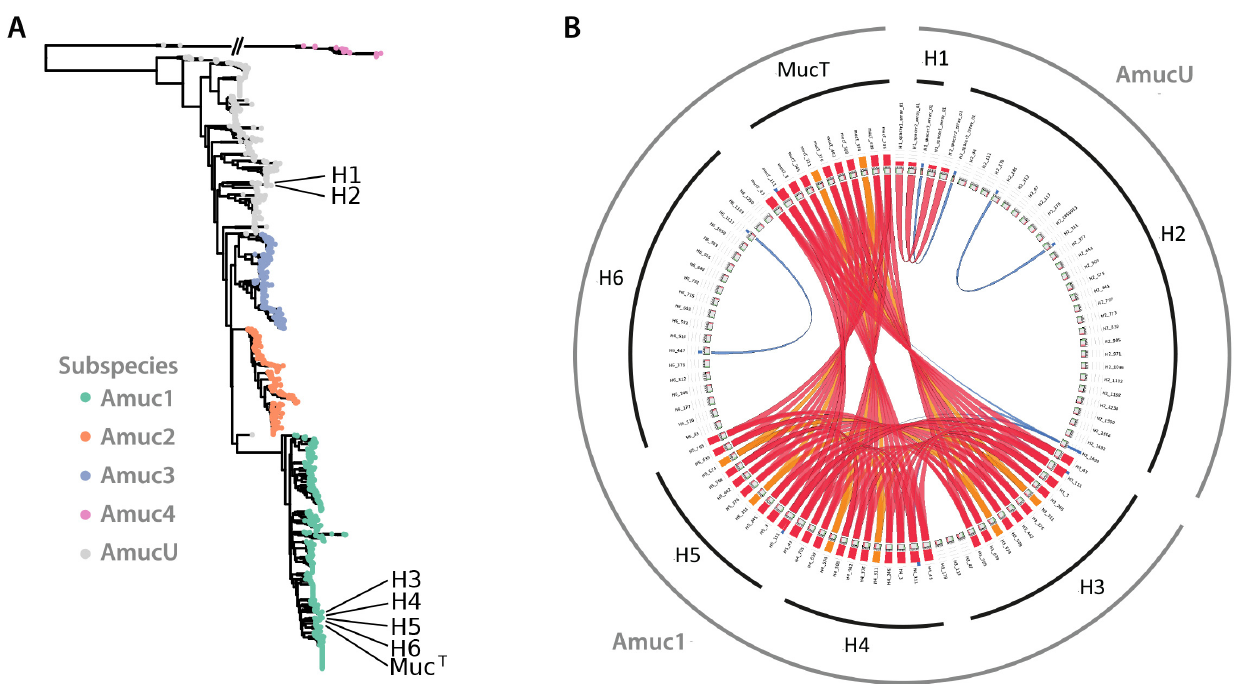
Figure 1. ( A ). Genome-based clustering of the new human isolates and the type-strain Muc T . The six new isolates (H1–H6) were positioned in the tree that was constructed earlier based on available (draft) genomes [22]. ( B ). Schematic representation of CRISPR repeats of the new human isolates and the type-strain Muc T . All CRISPR repeats are compared with each other. The red ribbons indicate a relatively high E-value (80% of max), orange indicates a lower E-value (max 60%), with blue depicting an E-value of maximum 20%. The newly isolated strains are visualized in the inner black circle. A. muciniphila subspecies are indicated in the outer grey circle.